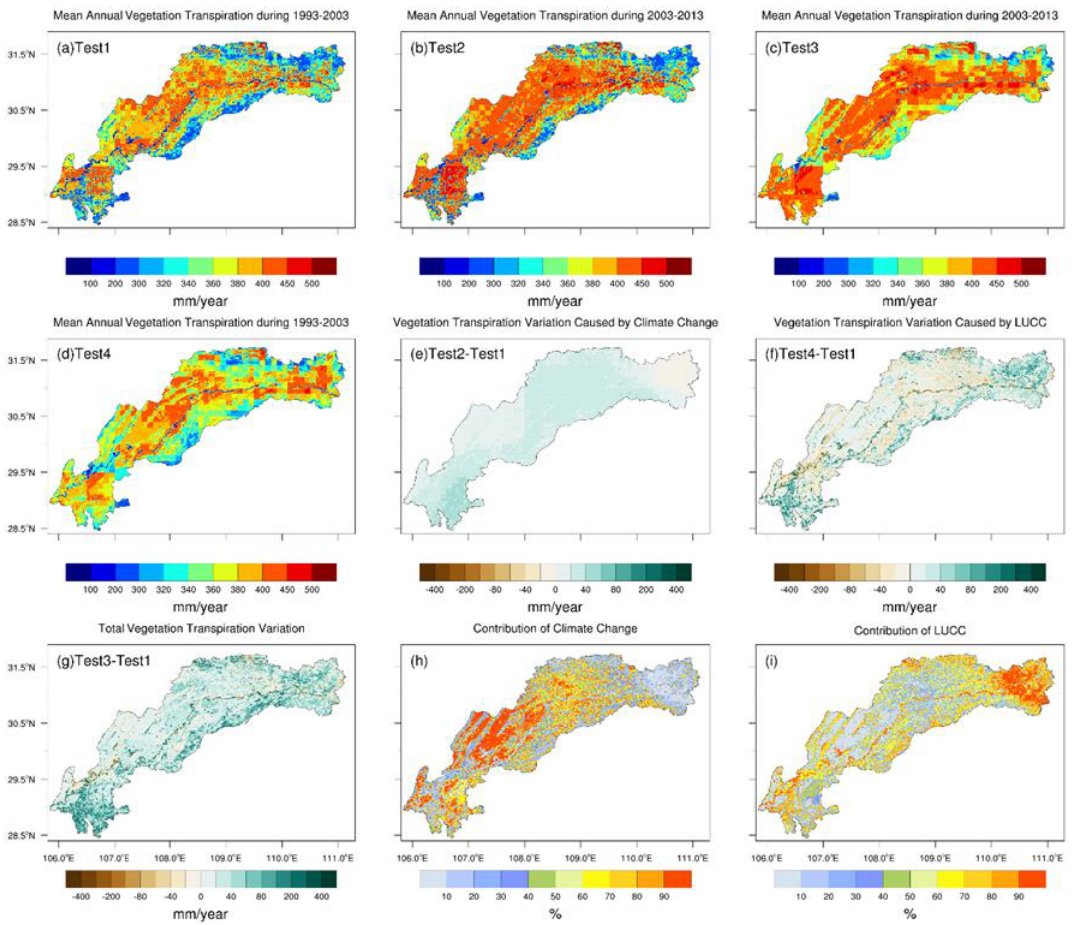
Figure 15. The spatial differences and the contribution of climate change and LUCC to vegetation transpiration before and after impoundment.